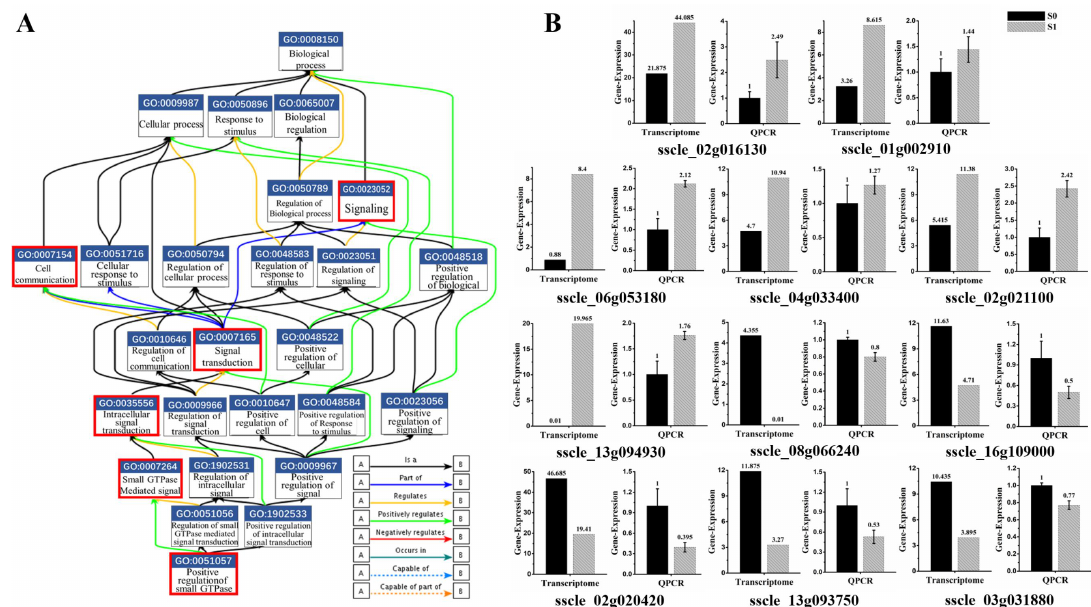
Figure 4. Small GTPase mediated signal transduction involved in SsHADV-1 virion infection. ( A ) Functional gene map from EMBL-EBI (The European Bioinformatics Institute). The box contains the GO number and functions, and different colored lines represent different relationships. The label in bottom-right corner is shown for details. The red box indicates the biological process by which DEGs are enriched. ( B ) DEGs were re-confirmed by RT-qPCR. Briefly, 11 DEGs (six up-regulated and five down-regulated DEGs) enriched in small G protein signaling pathways were selected. Three technical replicates were performed for each RT-qPCR. The ubiquitin gene was used as a reference